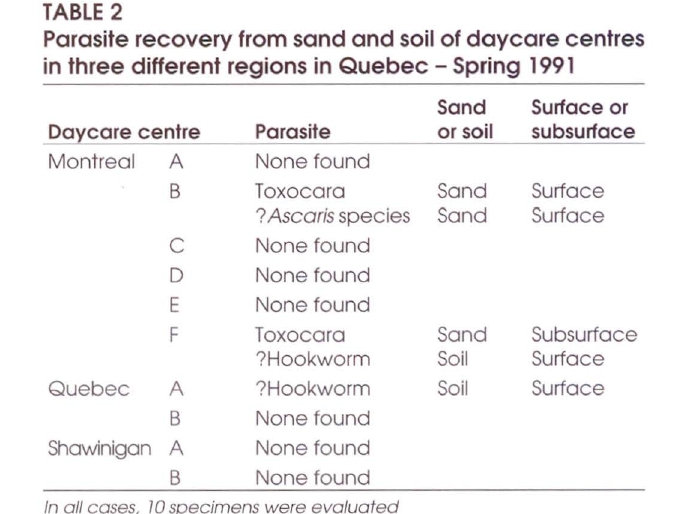
Parasite recovery from sand and soil of daycare centres in three different regions in Quebec - Spring